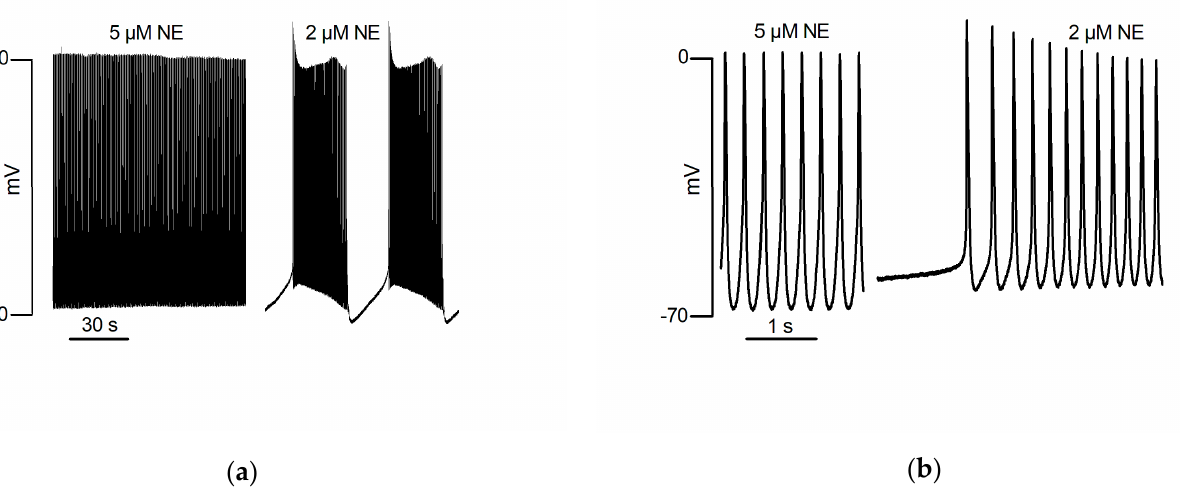
Figure 2. An intracellular microelectrode recording from an isolated PV of the rat. These traces form parts of an otherwise continuous recording during one penetration. ( a ) Automatic activity which had been evoked by the superfusion of 5 µ M NE presented as continuous firing (3.8 Hz) of action potentials arising from a diastolic membrane potential of − 69 mV, overshooting to +4 mV with a maximum rate of phase 0 depolarization of 5.4 V/s. Ten minutes after reducing the concentration of NE to 2 µ M, continuous firing was replaced by automatic activity representing as bursts separated by silent intervals. Details of individual automatic action potentials recorded under these conditions are shown upon an expanded scale in ( b